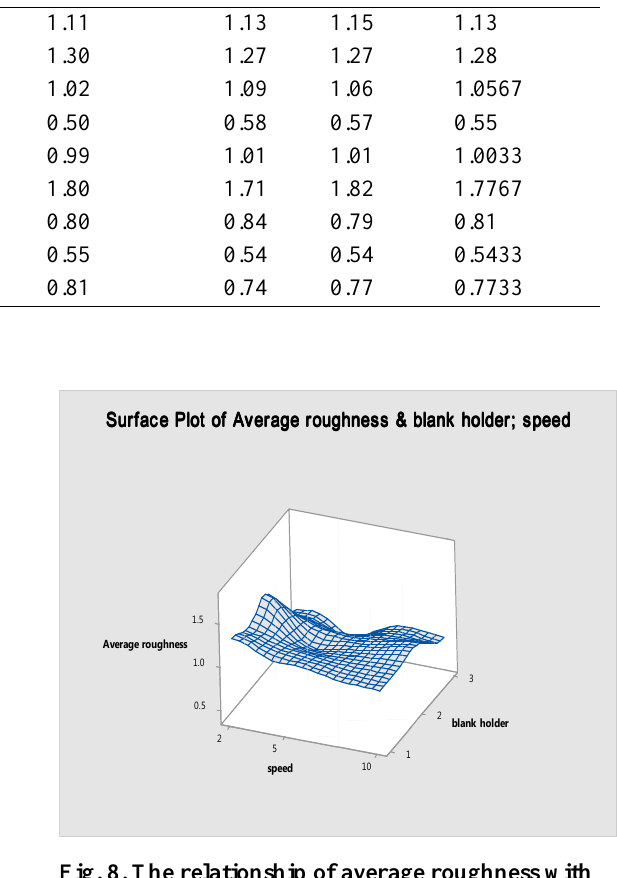
Fig. 8. The relationship of average roughness with respect to process parameters.